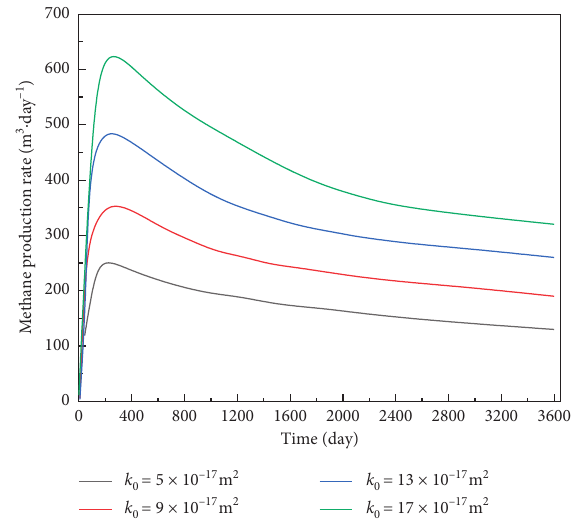
Figure 4: Variation of methane production rate with different initial coalbed